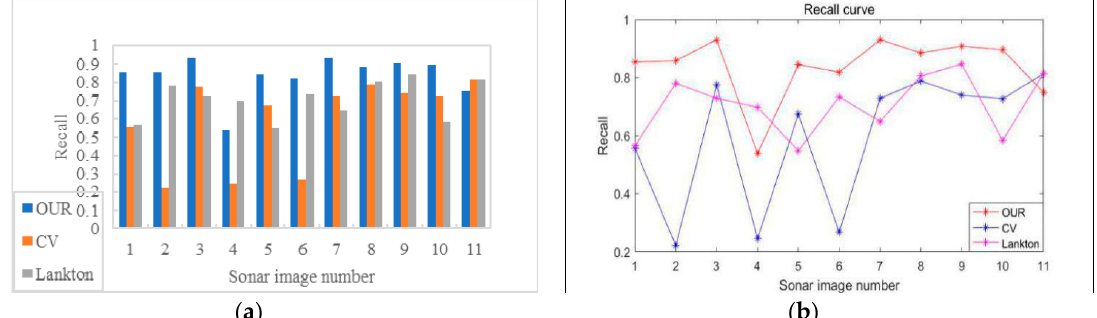
Figure 15. Recall curve. ( a ) Histogram of recall. ( b ) Line chart of recall.